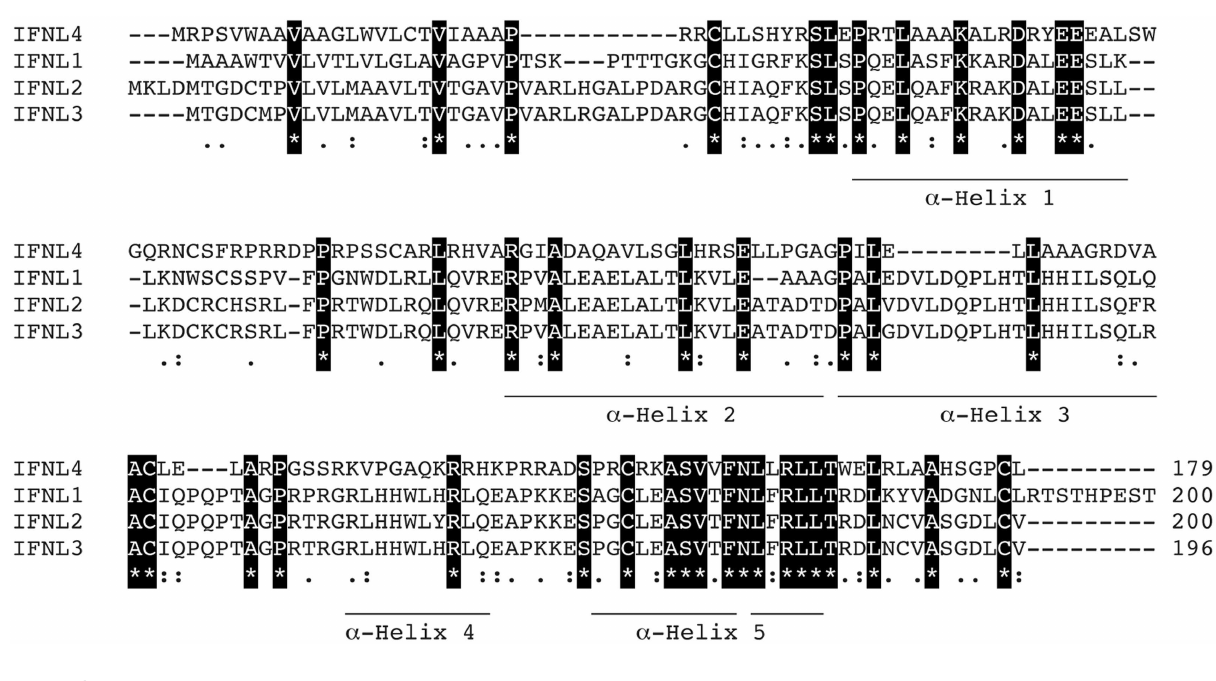
FIGURE 3 | Protein sequence analysis . Clustal multiple sequence alignment by MUSCLE (3.8) for IFN- λ s, IFNL1–4. Protein IDs are Q8IU54, Q8IZJ0, Q8IZI9, and K9M1U5-1, respectively. Identical amino-acids are shaded in